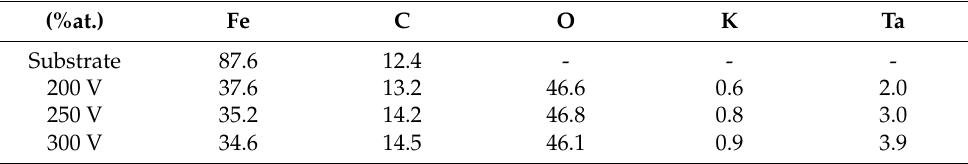
Table 1. Semi-quantitative EDS chemical analysis (±0.1) of the selected elements on the surface. (%at.)